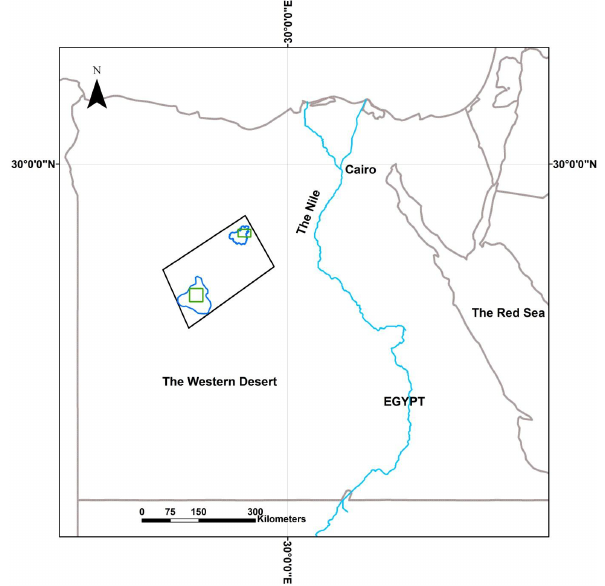
Fig. 1. Location map of the study area; the catchments of Farafra and Baharia depressions are outlined in blue, and the insets of satel- lite images are outlined by green